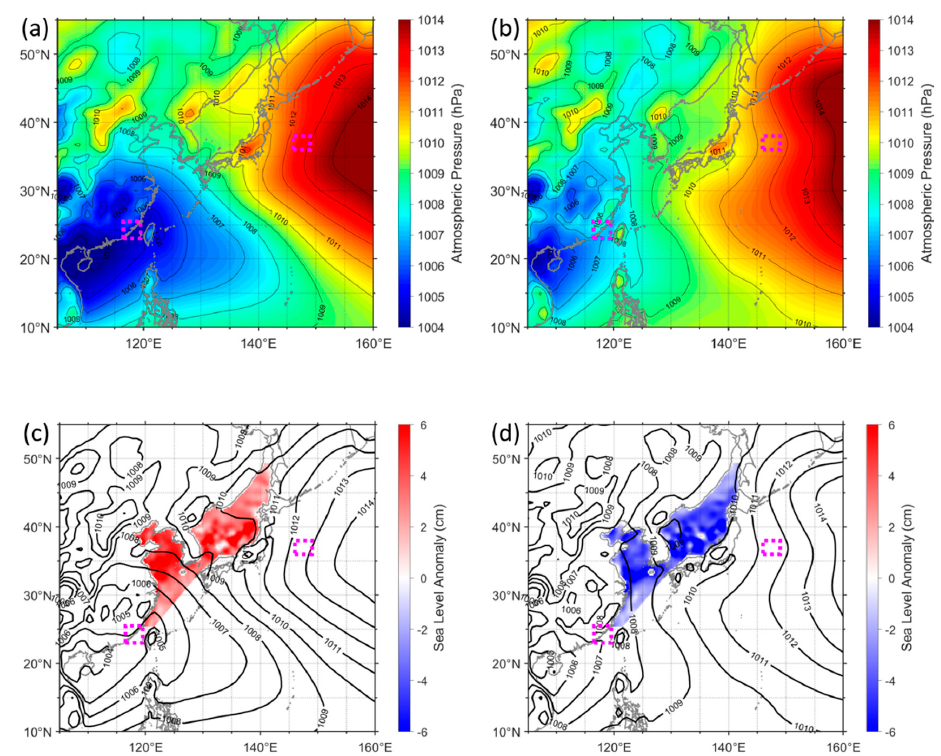
Figure 10. Atmospheric pressures in August averaged for the periods ( a ) H and ( b ) L in the northwest Pacific Ocean (contour intervals: 1 hPa). Atmospheric pressure contours with the colored August NEAMS sea-level anomaly (ANSA) (red: positive, blue: negative) for the periods ( c ) H and ( d ) L. The areas defining the August NEAMS sea-level index (ANSI) are denoted by the magenta dotted boxes, the same as in Figure 9. Coastlines are drawn in grey.